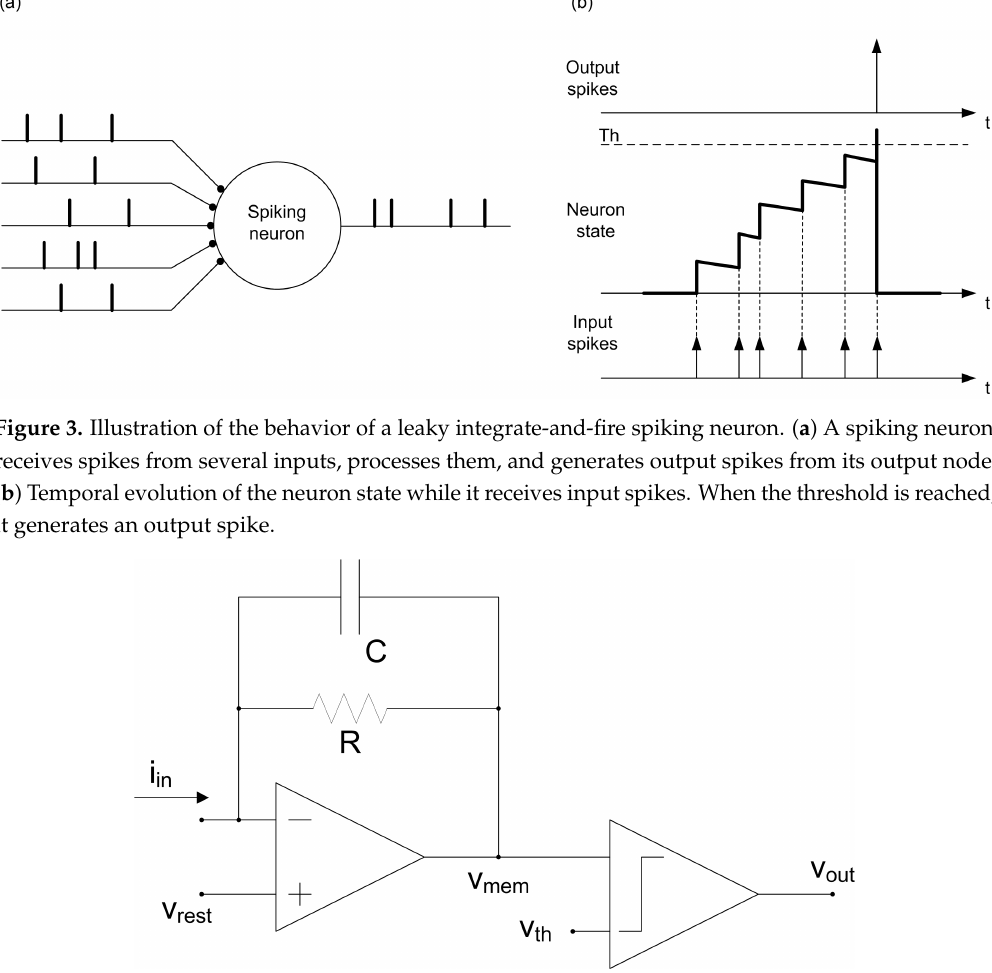
Figure 4. Example of a hardware implementation of an RC leaky integrate-and-fire